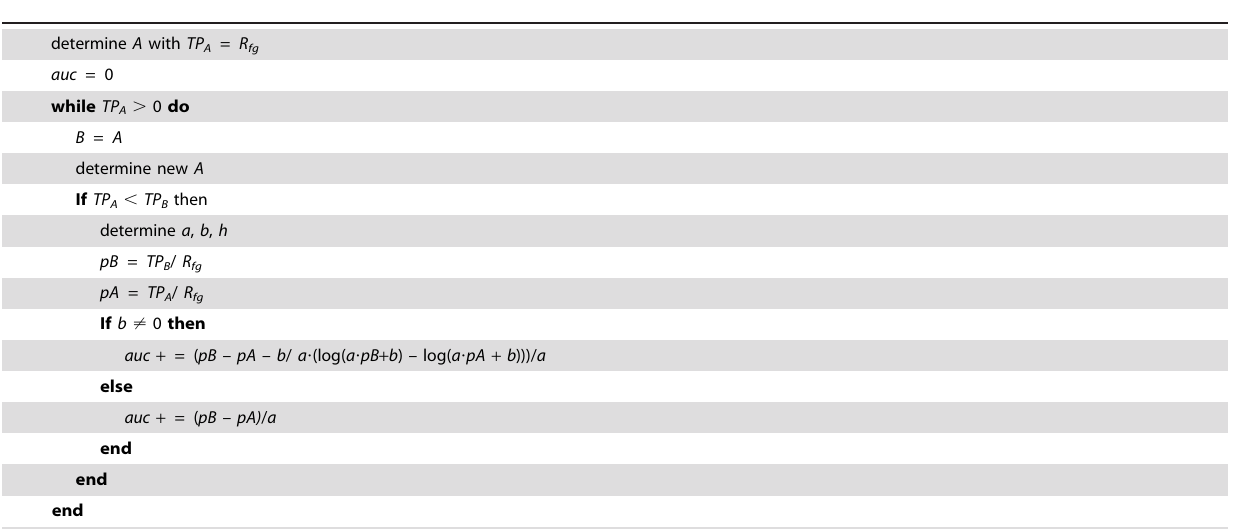
determine A with TP A = R